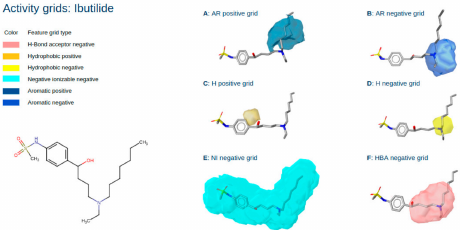
Figure 3. Structure of the known hERG blocker Ibutilide and its respective activity grids: aromatic positive grid (A); aromatic negative grid (B); hydrophobic positive grid (C); hydrophobic negative grid (D); negative ionizable grid (E); hydrogen bond acceptor negative grid